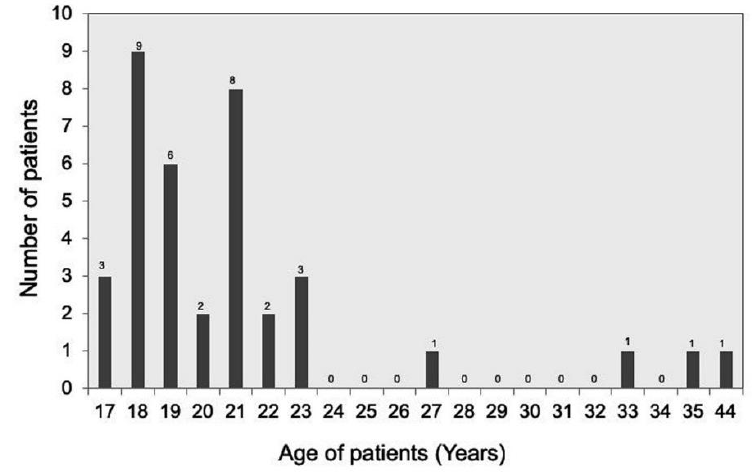
Figure 3. Age distribution of the 37 patients at the time of implant insertion.